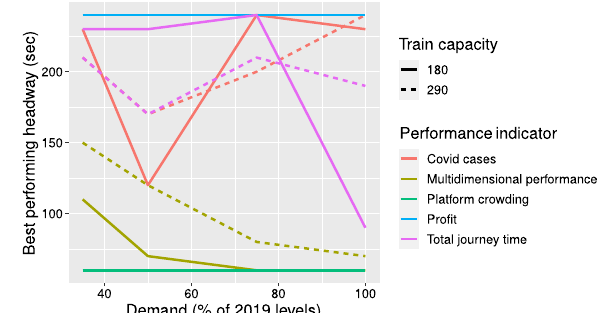
Figure 3. Best performing headway for different performance criteria for baseline Covid-19 multiplier of